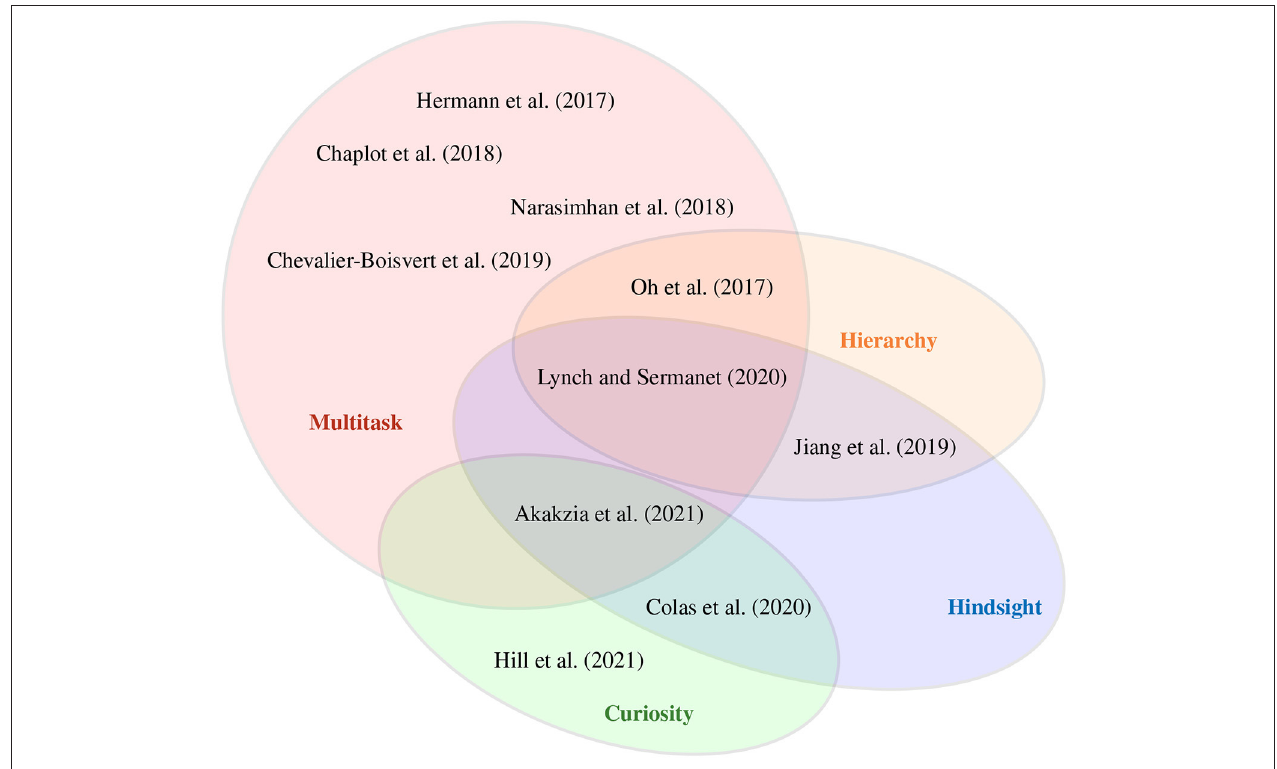
FIGURE 3 | A selection of reinforcement learning methods which we categorize according to their properties. Multitask RL involves methods that learn a policy to solve and transfer knowledge between different tasks. Hindsight learning allows to create and learn from imagined—(Colas et al., 2020) and relabeled goals (Akakzia et al., 2021). Methods using a hierarchy of policies/models are employed for temporal abstractions (Jiang et al., 2019; Lynch and Sermanet, 2021). Curiosity serves as an intrinsic signal to utilize self-supervision and overcome sparse extrinsic feedback (Colas et al., 2020; Akakzia et al., 2021; Hill et al., 2021). The methods with the largest overlaps, namely Lynch and Sermanet (2021) and Akakzia et al. (2021), integrate both essential and cognitive plausible